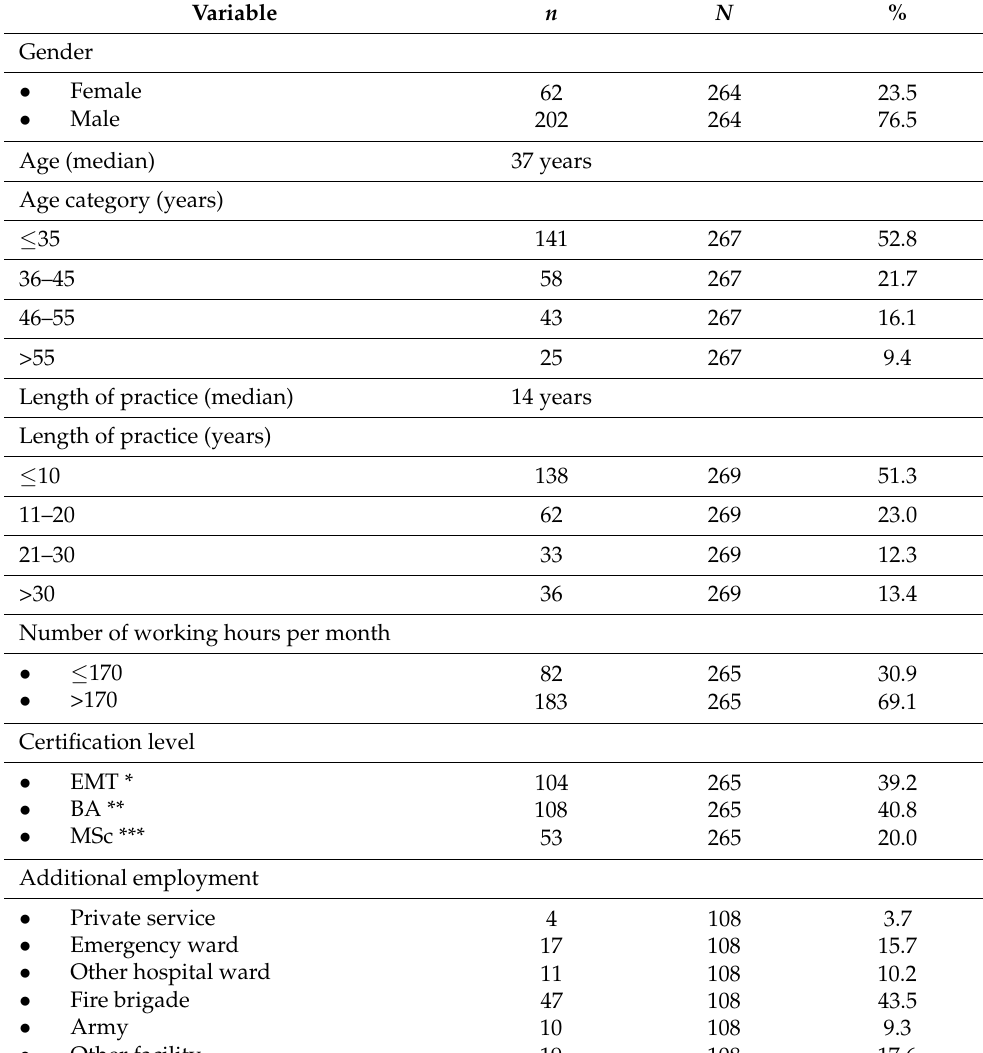
Table 1. Demographic characteristics of study participants ( n = 286).